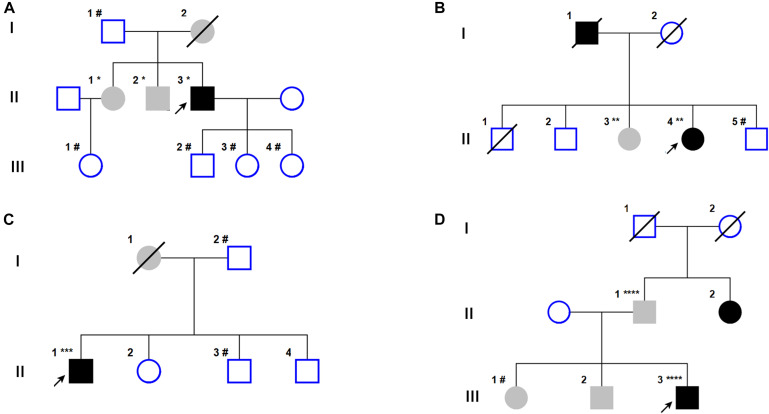
Pedigrees of the four families with TENM4 mutations involved in this study. (A–D) Pedigress of four different families with TENM4 mutations. Notes: black symbols, individuals with ET and PD; blank symbols, unaffected; gray symbols, individuals who are reported to have ET by history but some are not examined; arrow, probands; diagonal lines, deceased individuals; circle, female; square, male. ∗: c.974 G > A/wild type; ∗∗: c.2287 C > T/wild type; ∗∗∗: c.6209 G > A/wild type; *⁣*⁣**: c.5545 A > G/wild type; #: wild type/wild type.